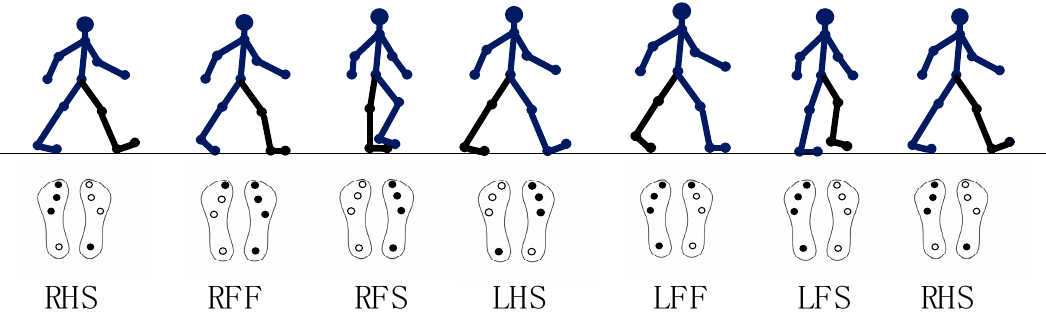
Figure 9. Phase division of walking cycle. RHS (Right heel strike): At this stage, the left foot pressure decreases, the right foot pressure increases, and the support center of gravity begins to shift to the right foot. RFF (Right foot flat): At this stage, the support center of gravity is completely transferred to the right foot, and the left foot enters the swing period. RFS (Right foot support): At this stage, the left foot ends the swing period and begins to touch the ground. LHS (Left heel strike): This stage is the bipedal support stage before the right foot swings. The right foot pressure decreases, the left foot pressure increases, and the support center of gravity begins to shift to the left foot. LFF (Left foot flat): At this stage, the support center of gravity is completely transferred to the left foot, and the right foot enters the swing period. LFS (Left foot support): At this stage, the right foot ends the swing phase and is ready to touch down.